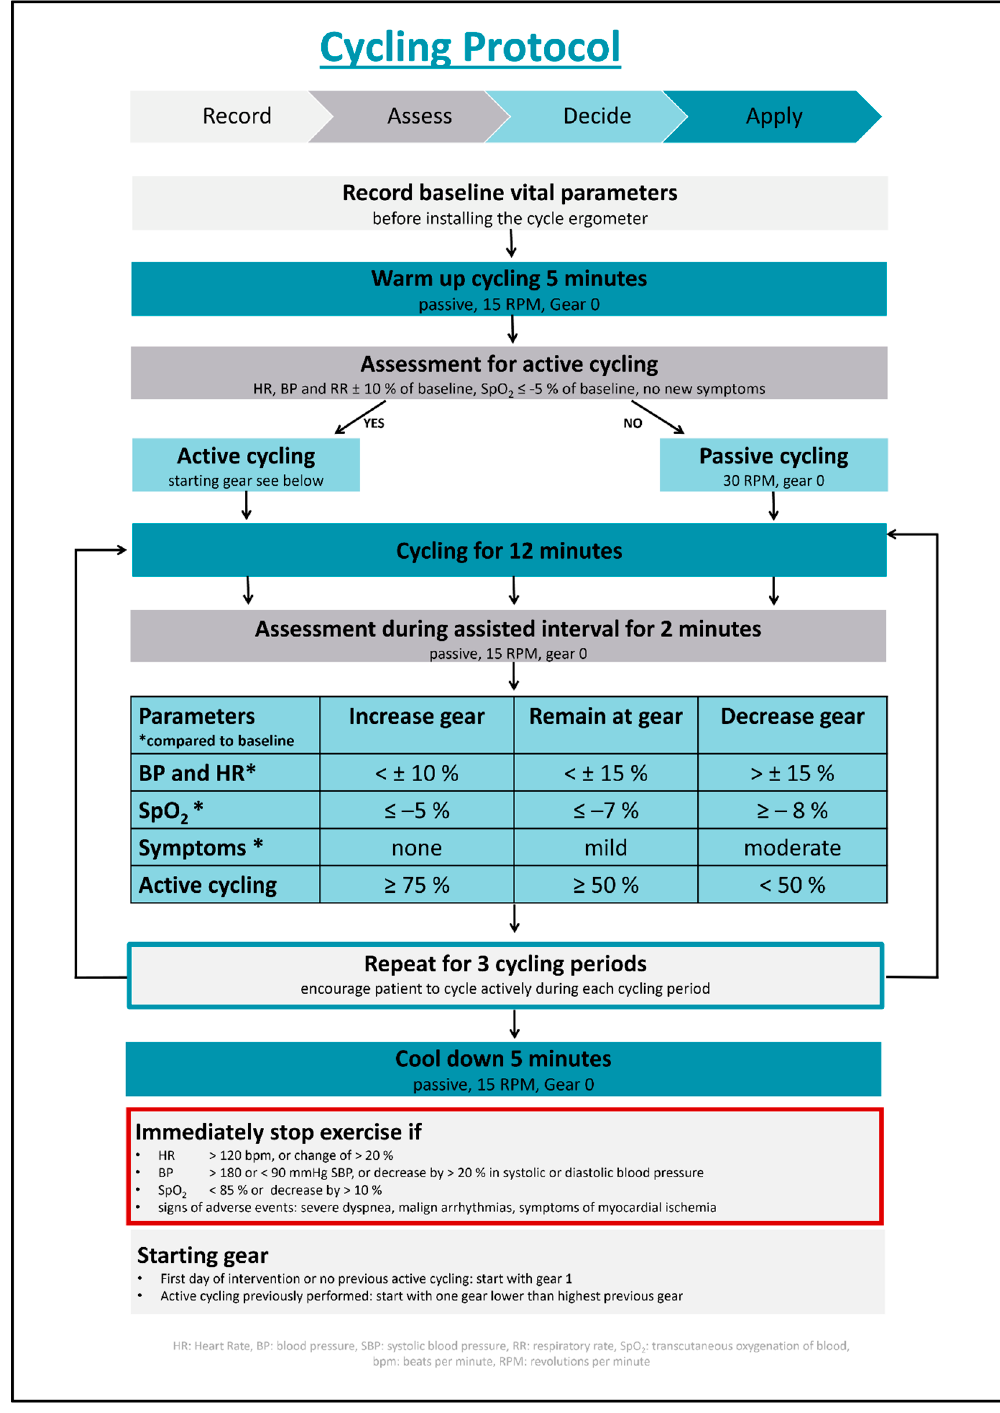
Figure 1. Cycling protocol. Abbreviations: BP: blood pressure, HR: heart rate, RPM: rotations per minute, RR: blood pressure; SPO 2 : transcutaneous oxygen saturation.